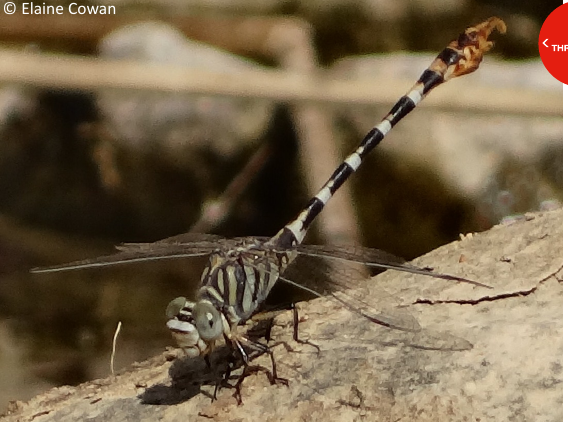
Image 13. Female Paragomphus sinaiticus , 17 May 2014. Abdomen less clearly marked than male, sandy and cream coloured with dark brown and light rings. No terminal appendage hooks